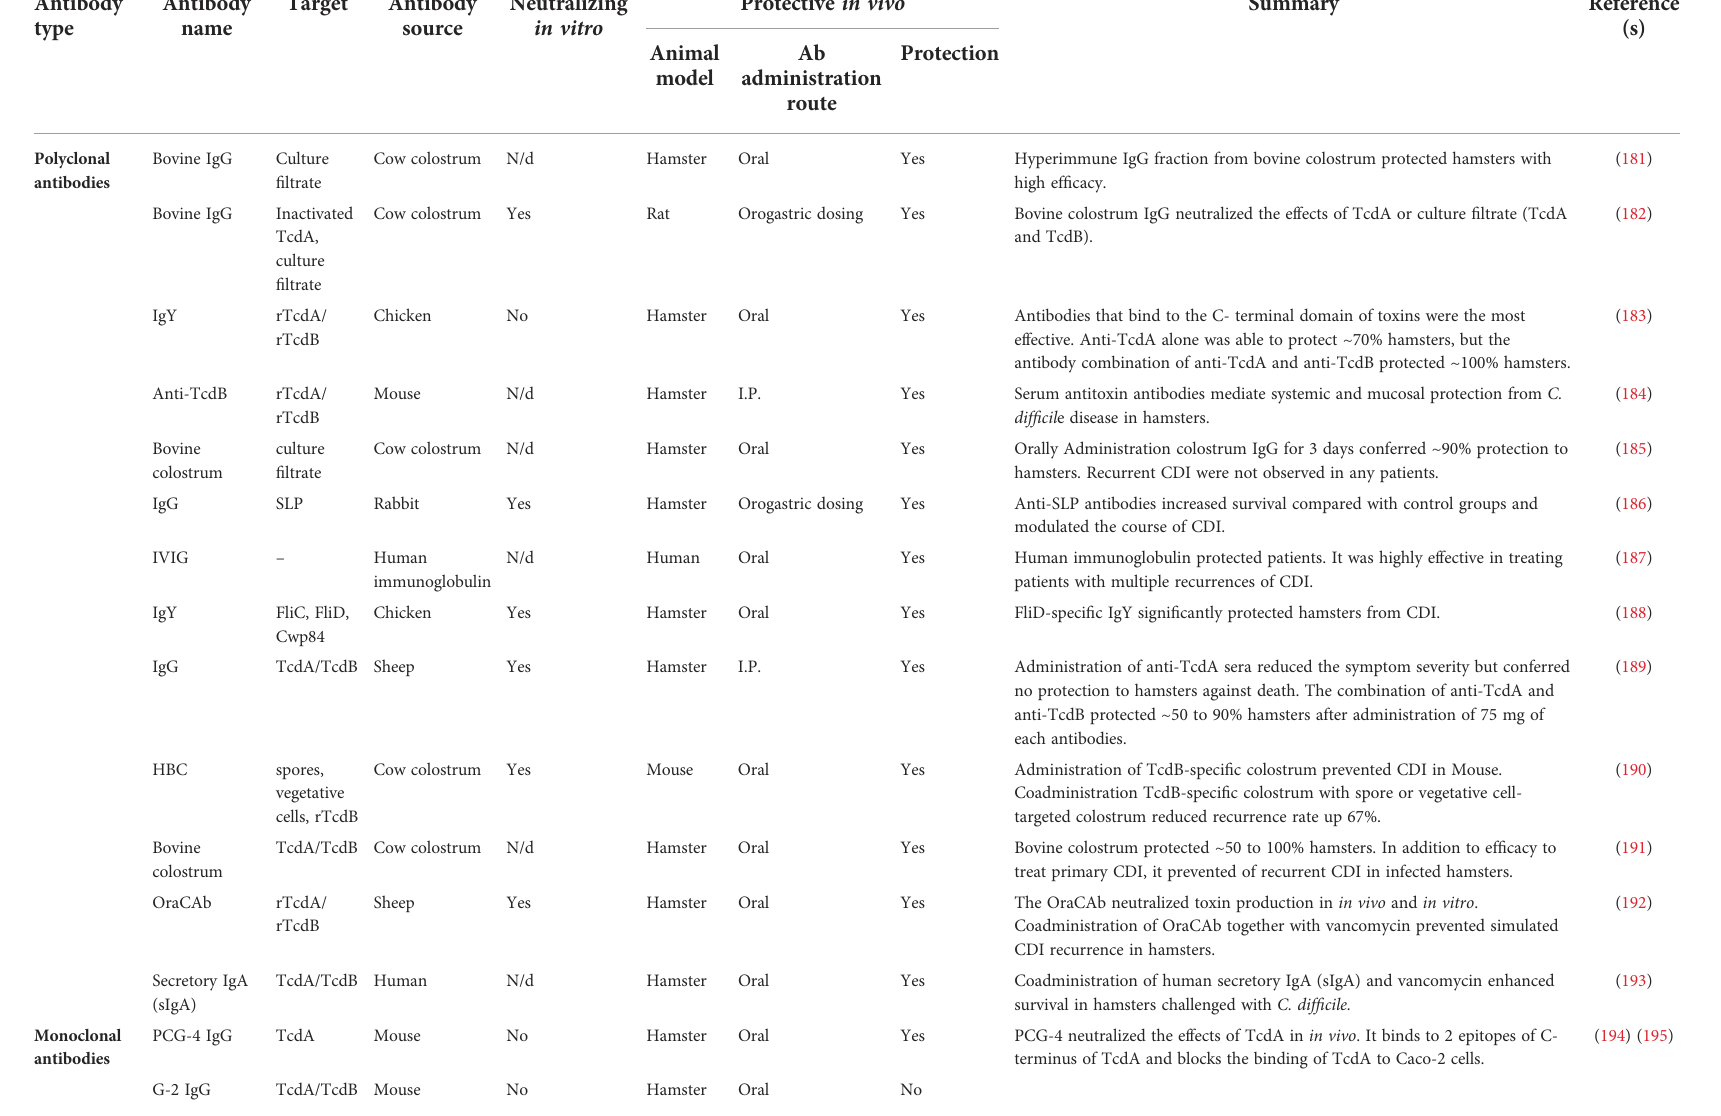
Table 2 Summaries of antibodies used in the study of Clostridioides dif fi cile